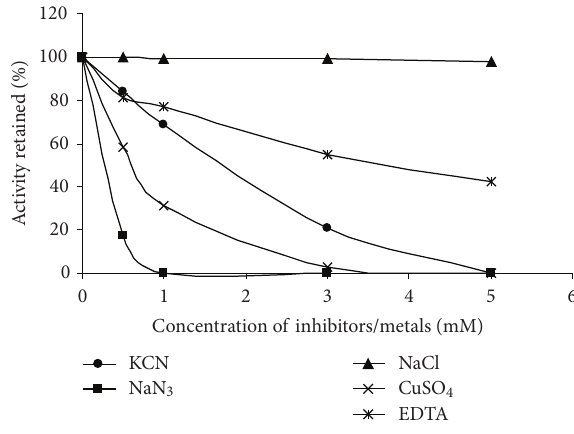
F1:EffectsofvariouscompounsonCATfrom Malvasylvestris